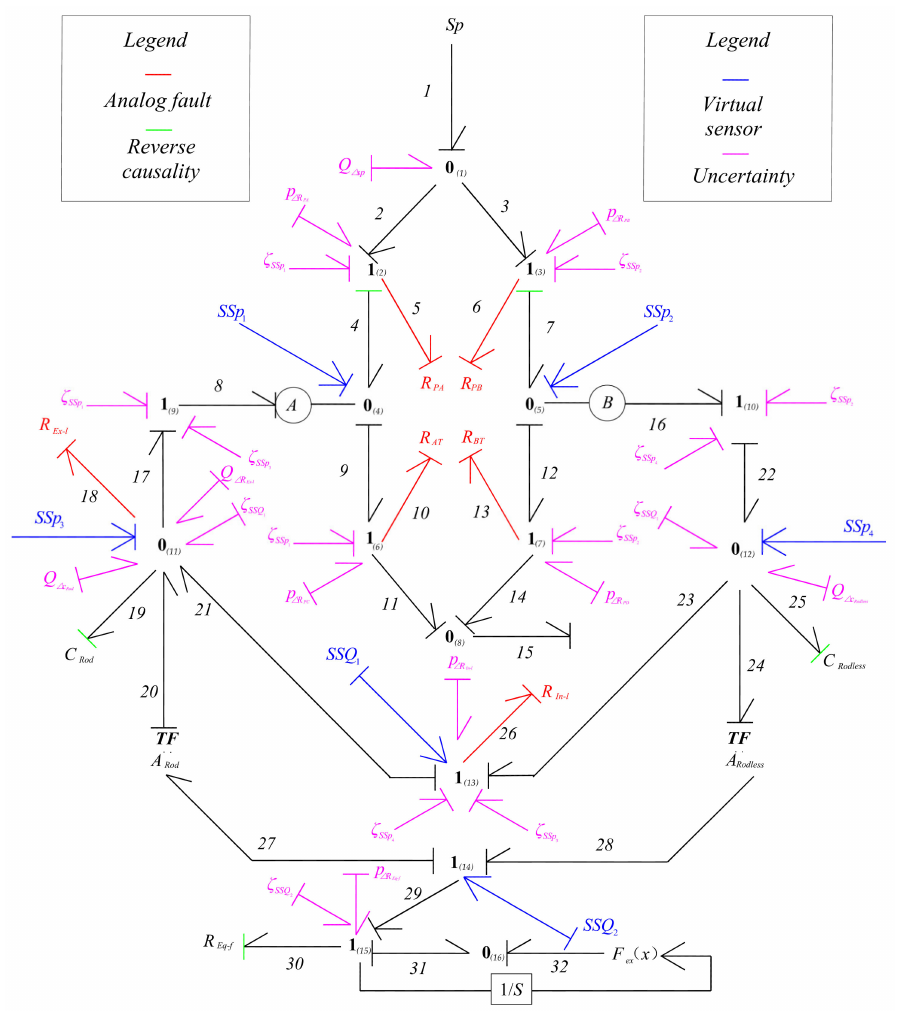
Figure 13. System diagnostic bond graph considering uncertain interference